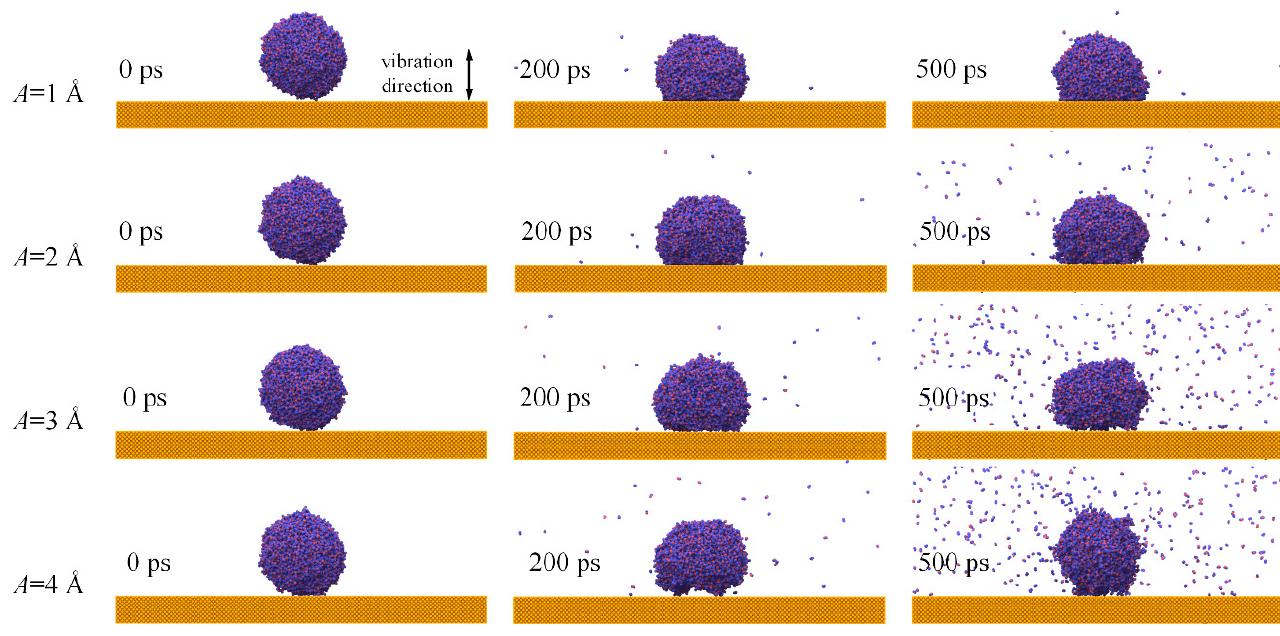
Figure 11. Time evolution of spreading factors in x and y directions: ( a ) β x ; ( b ) β y .